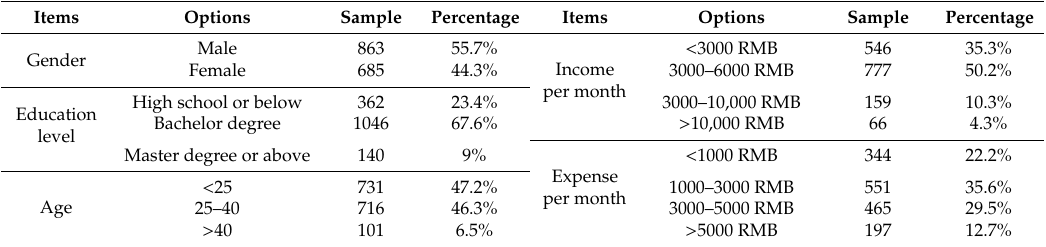
Table 1. Demographic information of the sample (N =